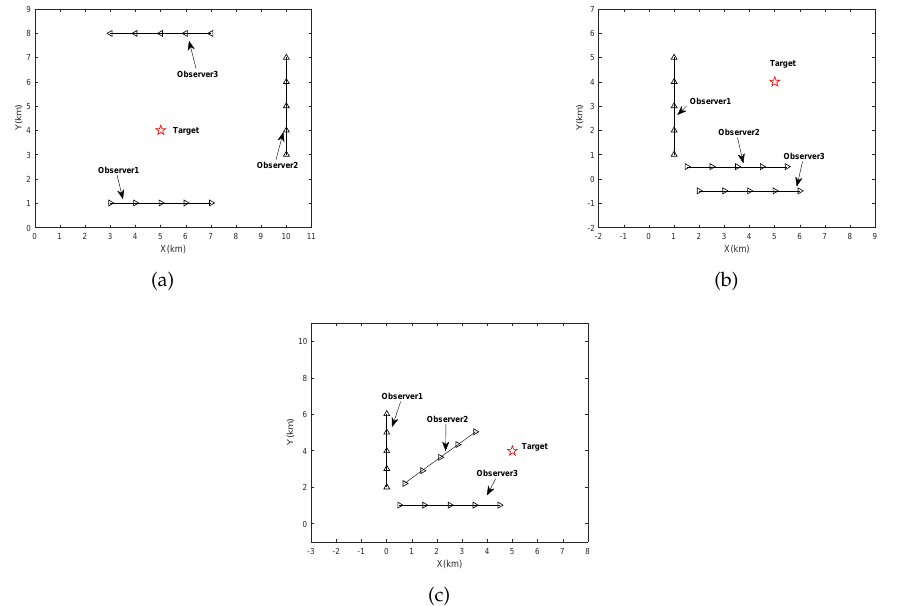
Figure 1. The simulated localization scenarios: ( a ) scenario 1, ( b ) scenario 2, ( c ) scenario